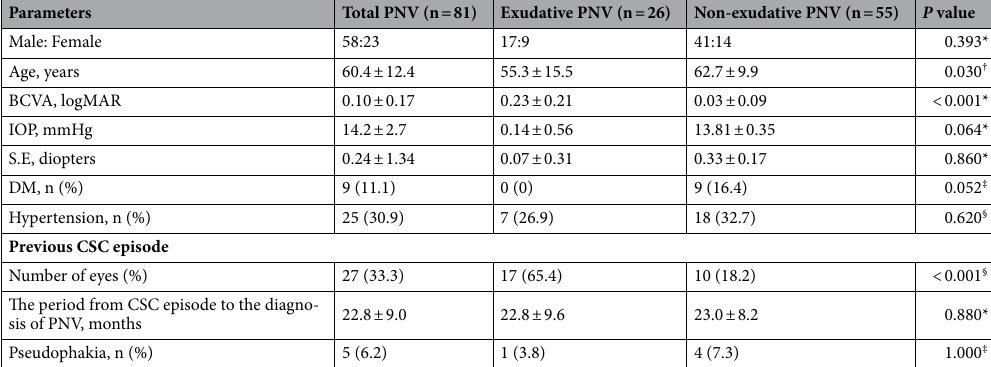
Table 1. Baseline demographics. PNV, pachychoroid neovasculopathy; BCVA, best-corrected visual acuity; logMAR, logarithm of the minimum angle of resolution; S.E, Spherical equivalent; DM, Diabetes mellitus; CSC, Central serous chorioretinopathy. Continuous variables are reported as mean value (± SD). *Mann whiney test; † Independent t -test; ‡ Fisher’s exact test; § Chi-square test.